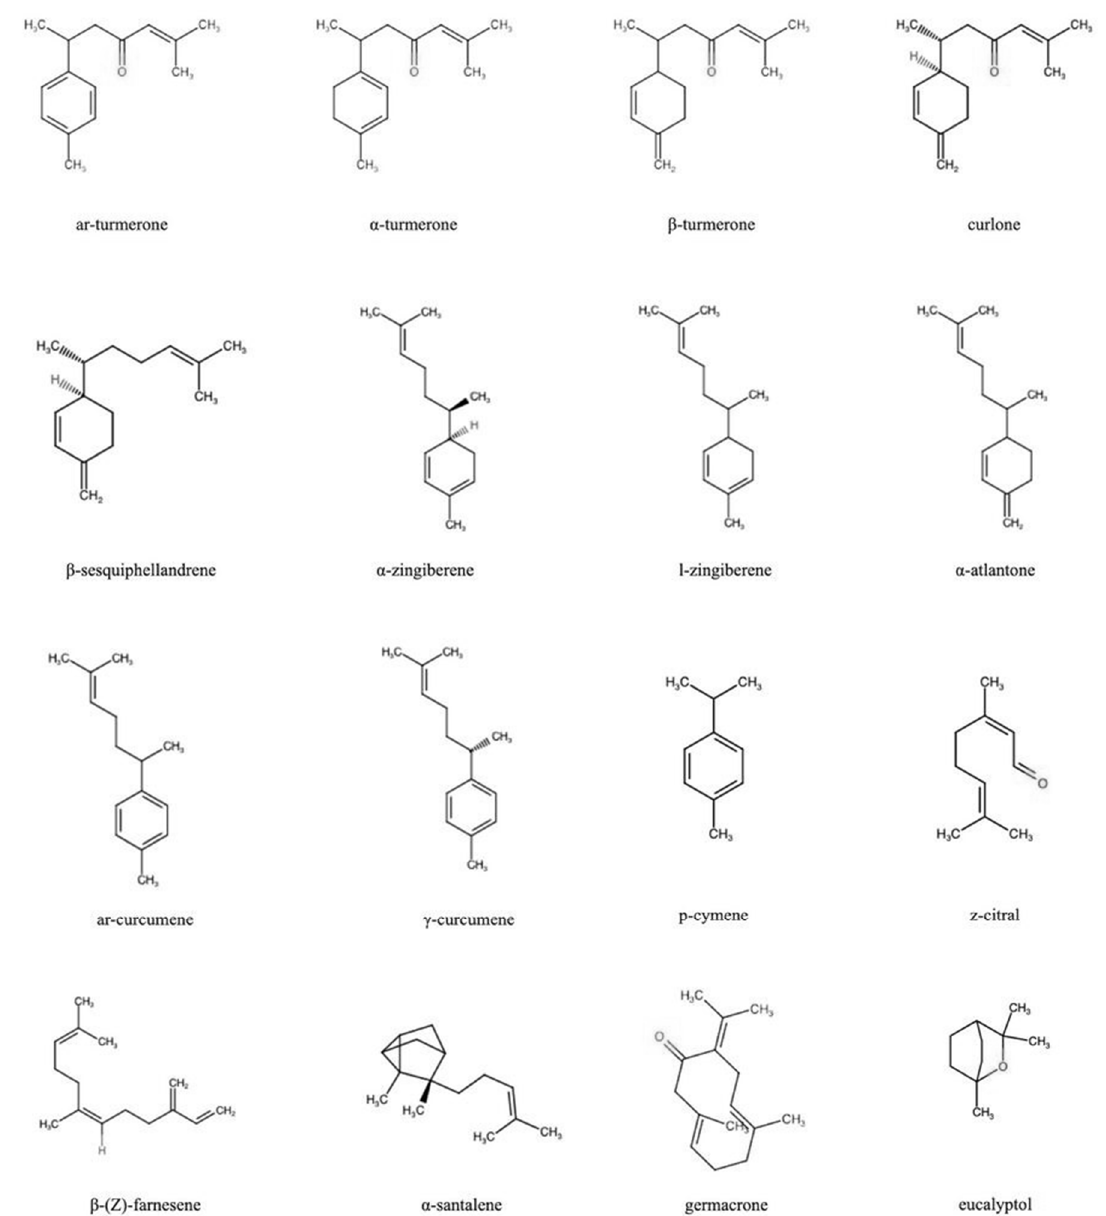
Figure 1. Chemical structure of bioactive turmeric oil constituents.